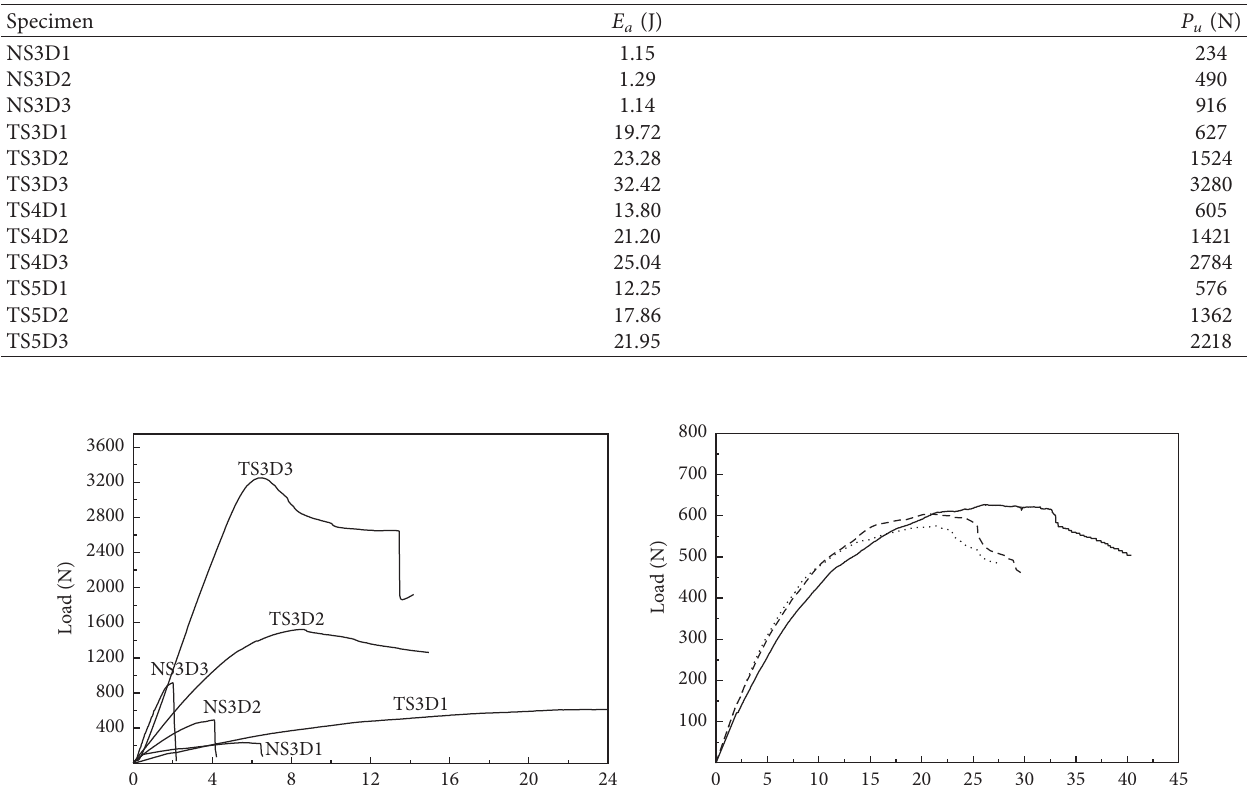
Table 4: Absorbed energy and peak load of